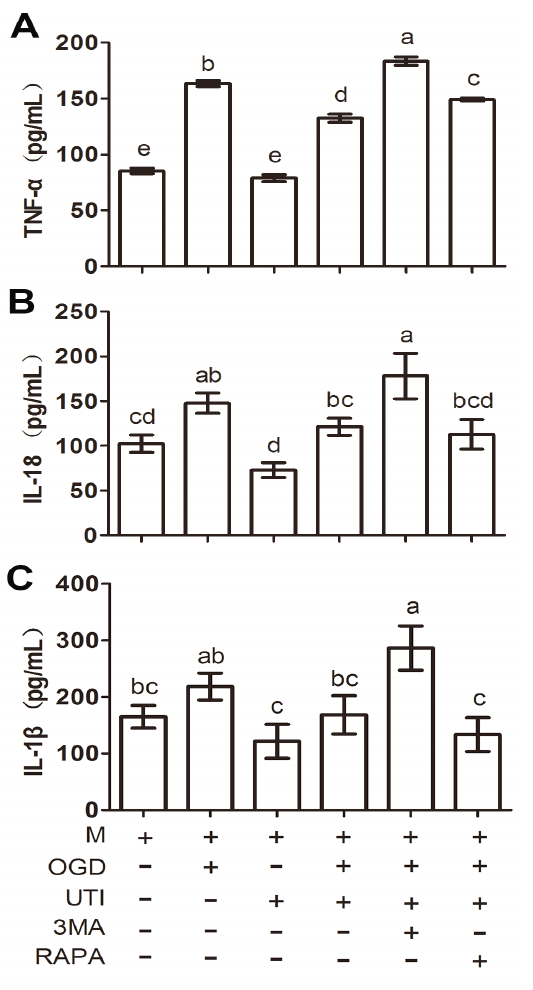
Figure 3: UTI regulated the expression of inflammatory cytokines in macrophages. A: ELISA analysis of the concentration of THF-α in macrophage culture supernatant; B: The concentration of IL-18 in macrophage culture supernatant; C: The concentration of IL-1β in macrophage culture supernatant by ELISA analysis. M: Macrophage; OGD: Oxygen glucose deprivation; UTI: Ulinastatin; 3MA: 3-Methyladenine; RAPA: Rapamycin. Bars with different letters are significantly different (p < 0.05).